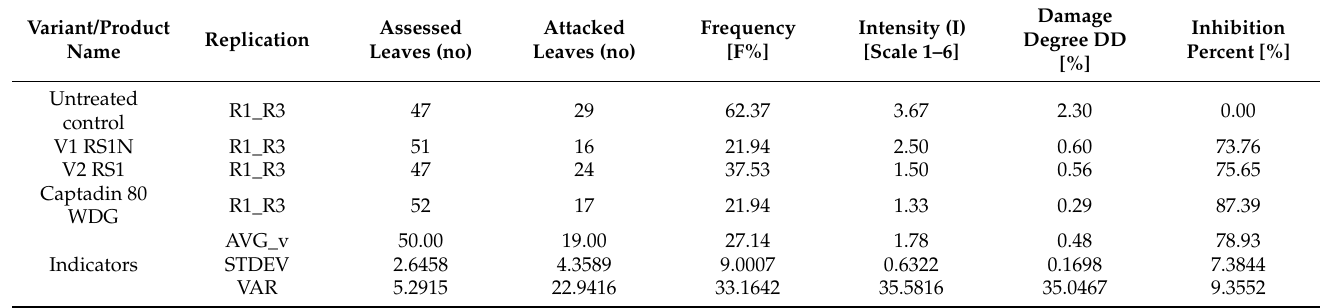
Table 5. Effect of vegetal extracts in control of apple scab— Venturia inaequalis